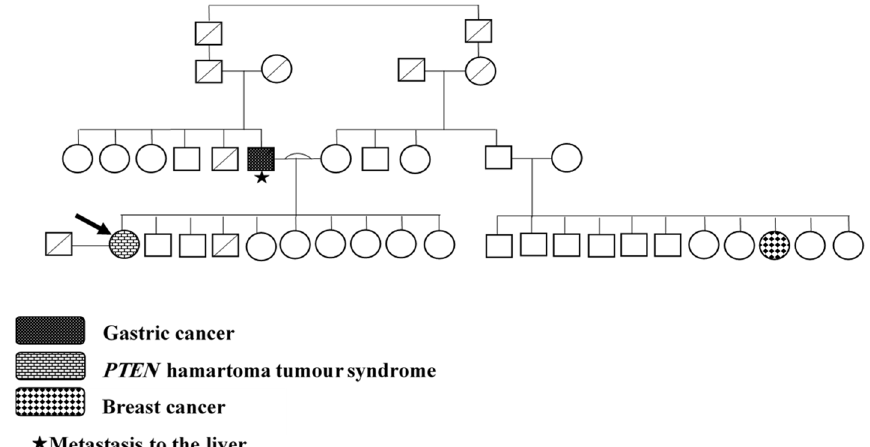
Fig. 1 Family tree of the patient, with squares representing men and circles women. Arrow indicates the